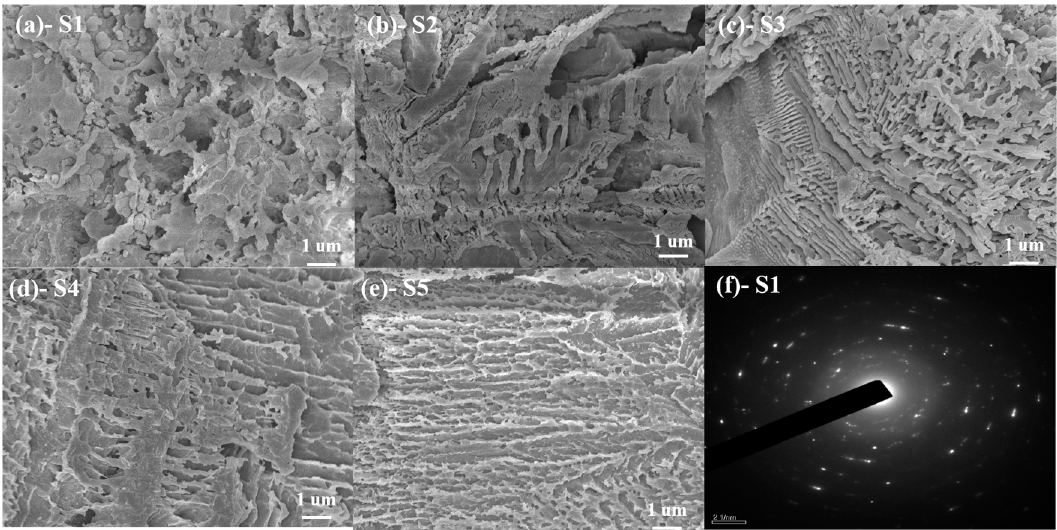
Figure 9. ( a – e ) SEM images of S1–S5 treated at 950 °C for 1 h. ( f ) TEM image of S1 quenched by water.